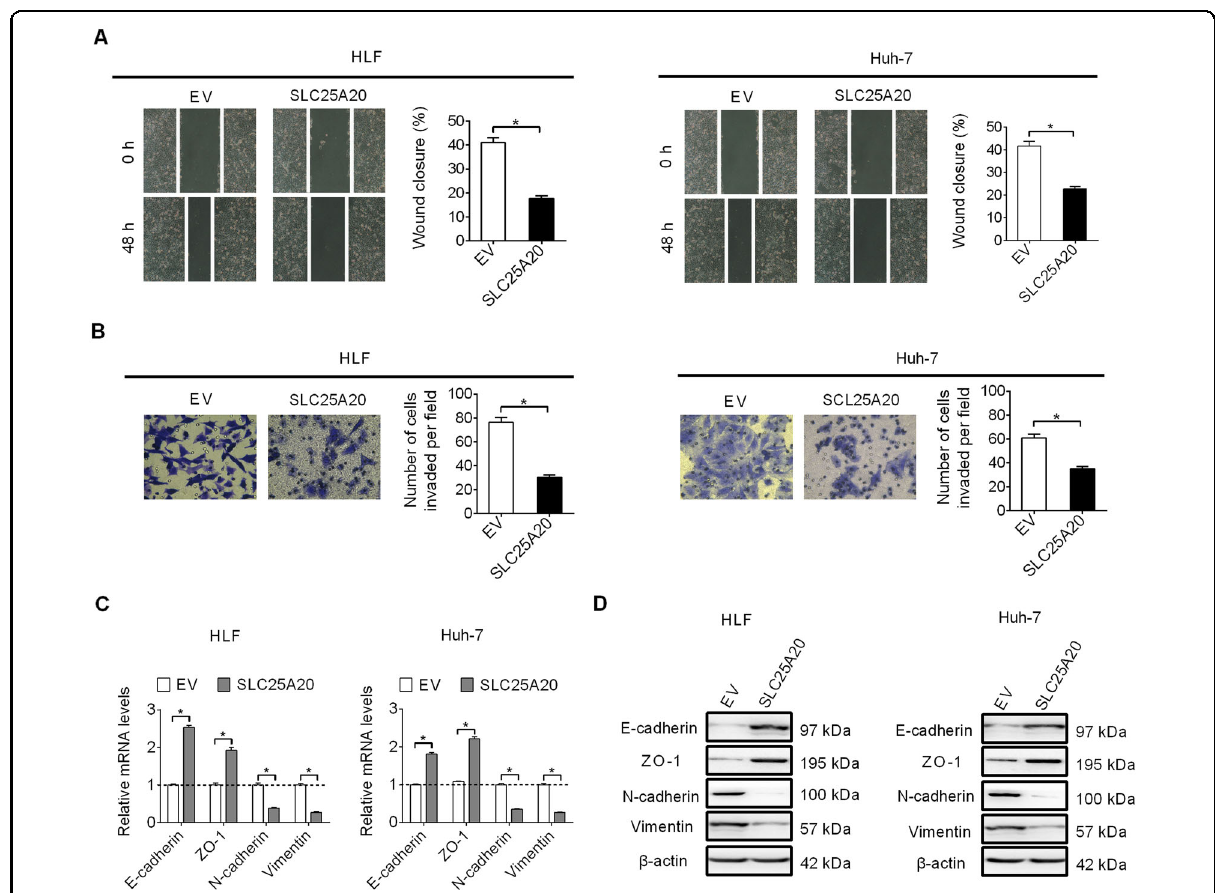
Fig. 3 Forced expression of SLC25A20 inhibited HCC cell invasion and migration through suppression of epithelial – mesenchymal transition (EMT). A Cell migration ability was assessed using wound-healing assay in HLF and Huh-7 cells with treatment as indicated (SLC25A20, expression vector encoding SLC25A20; EV, empty vector). B Cell invasion ability was assessed by transwell matrigel-invasion assay in HLF and Huh-7 cells with treatment as indicated. C , D The expressions of EMT markers were determined by quantitative real-time PCR and Western blot analysis in HLF and Huh-7 cells with treatment as